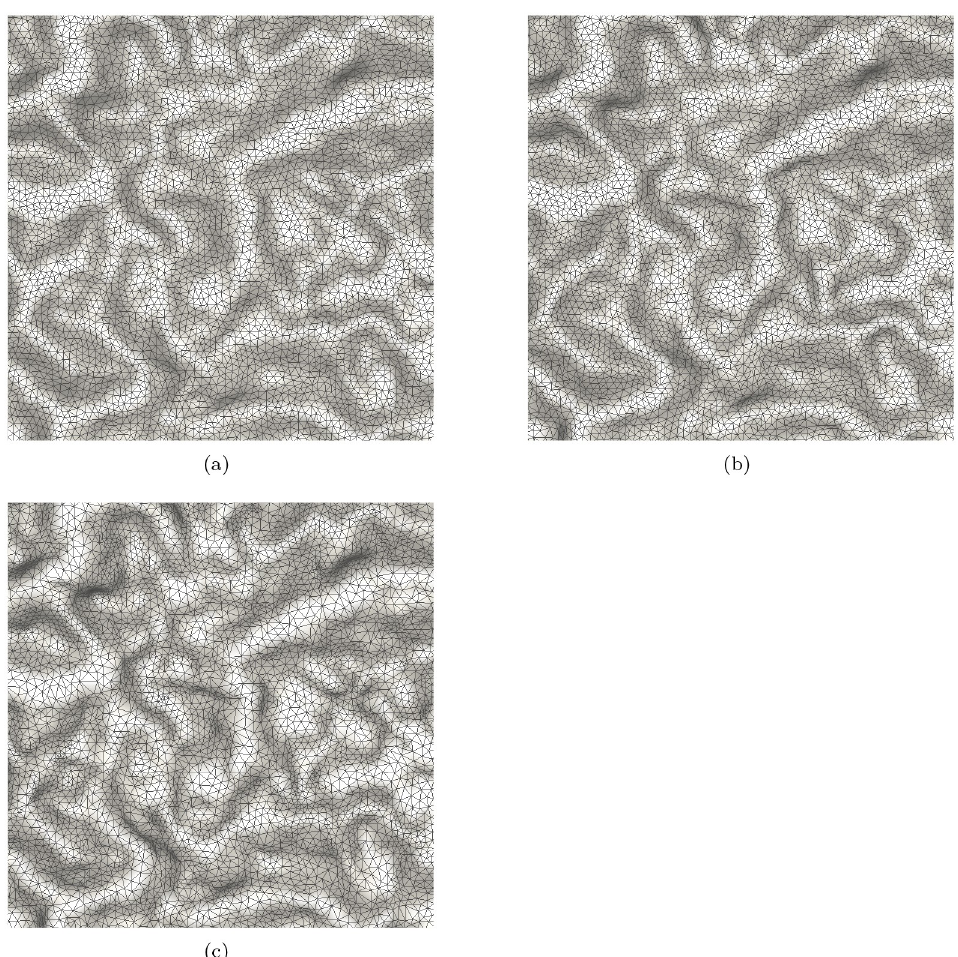
Fig 5. The sampling results of a DEM on basis of MPS. (a), (b) and (c) correspond to the cases of Euclidean distance, geodesic distance and the weighted geodesic distance. It should be mentioned that the numbers of samples are same for three